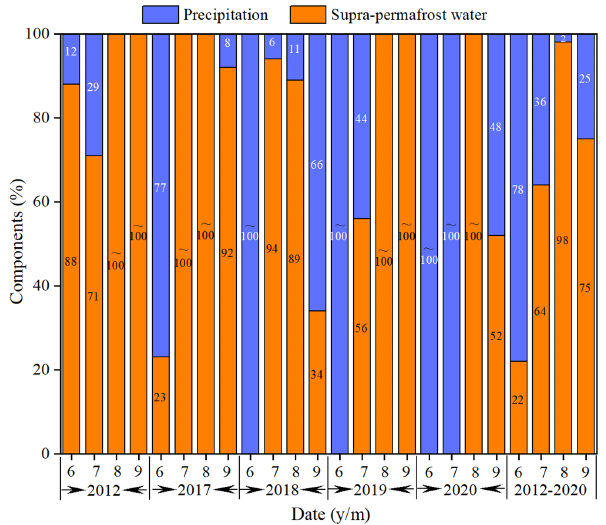
Figure 7. Monthly variation in components in stream water. “ ∼ ” indicates approximate estimation of component contributions to stream